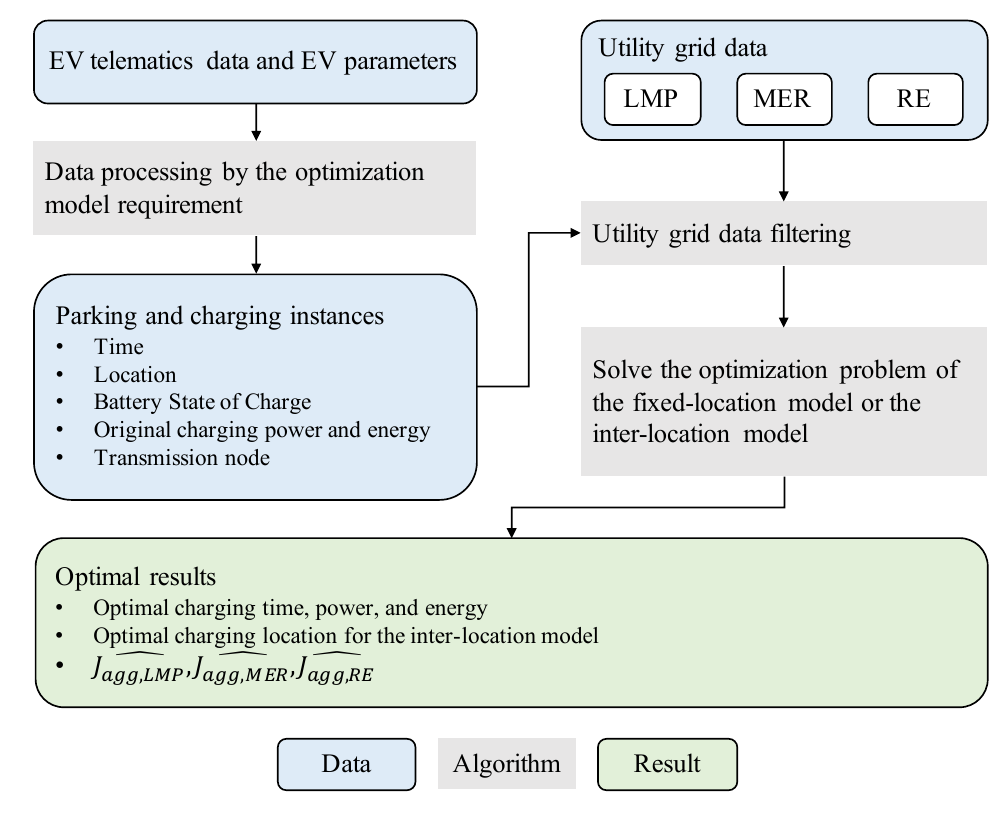
Figure 4. Data flow of the EV-charging